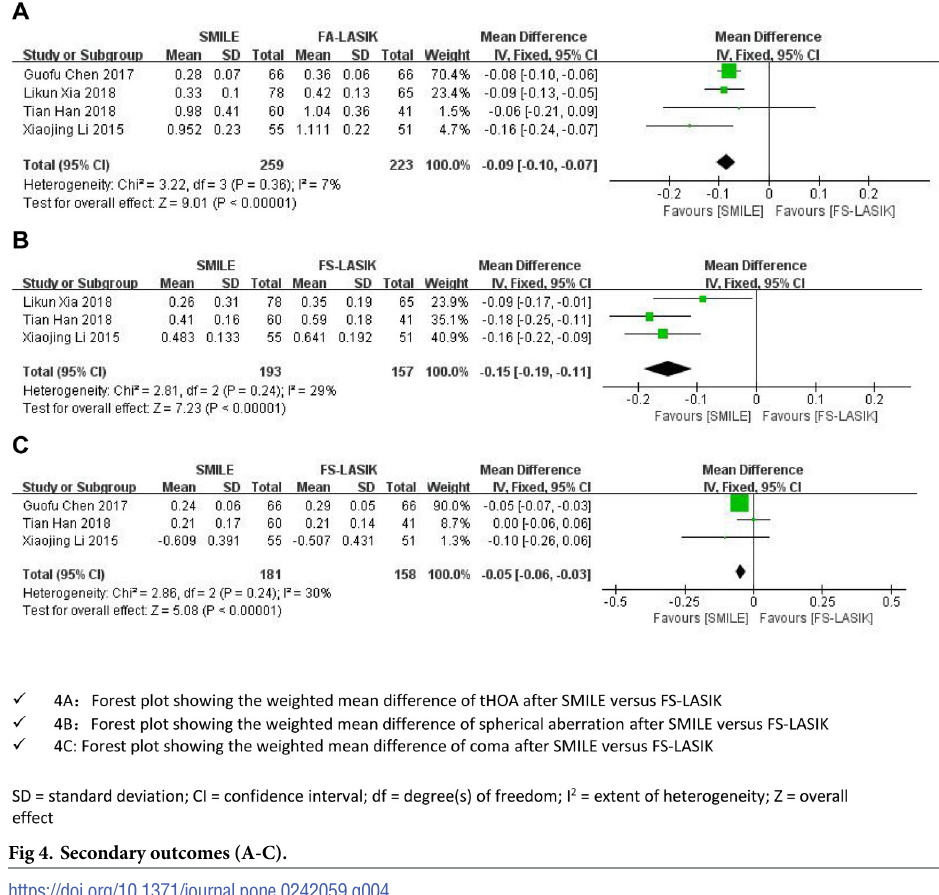
Fig 4. Secondary outcomes